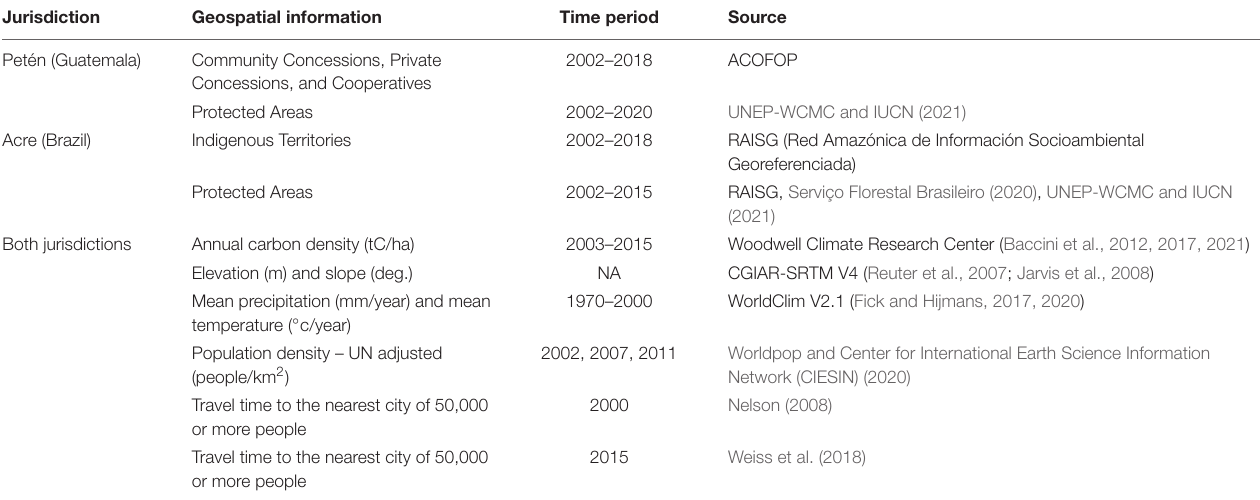
TABLE 2 | Geospatial data included in the